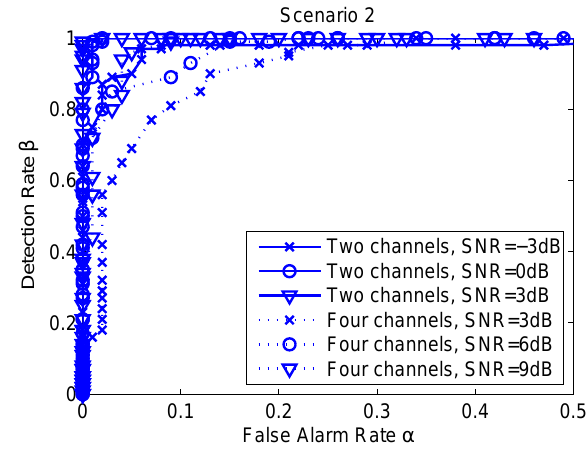
Figure 14. ROC curves in Scenario 2 under different SNR conditions in the cases of two channels and four channels, respectively.